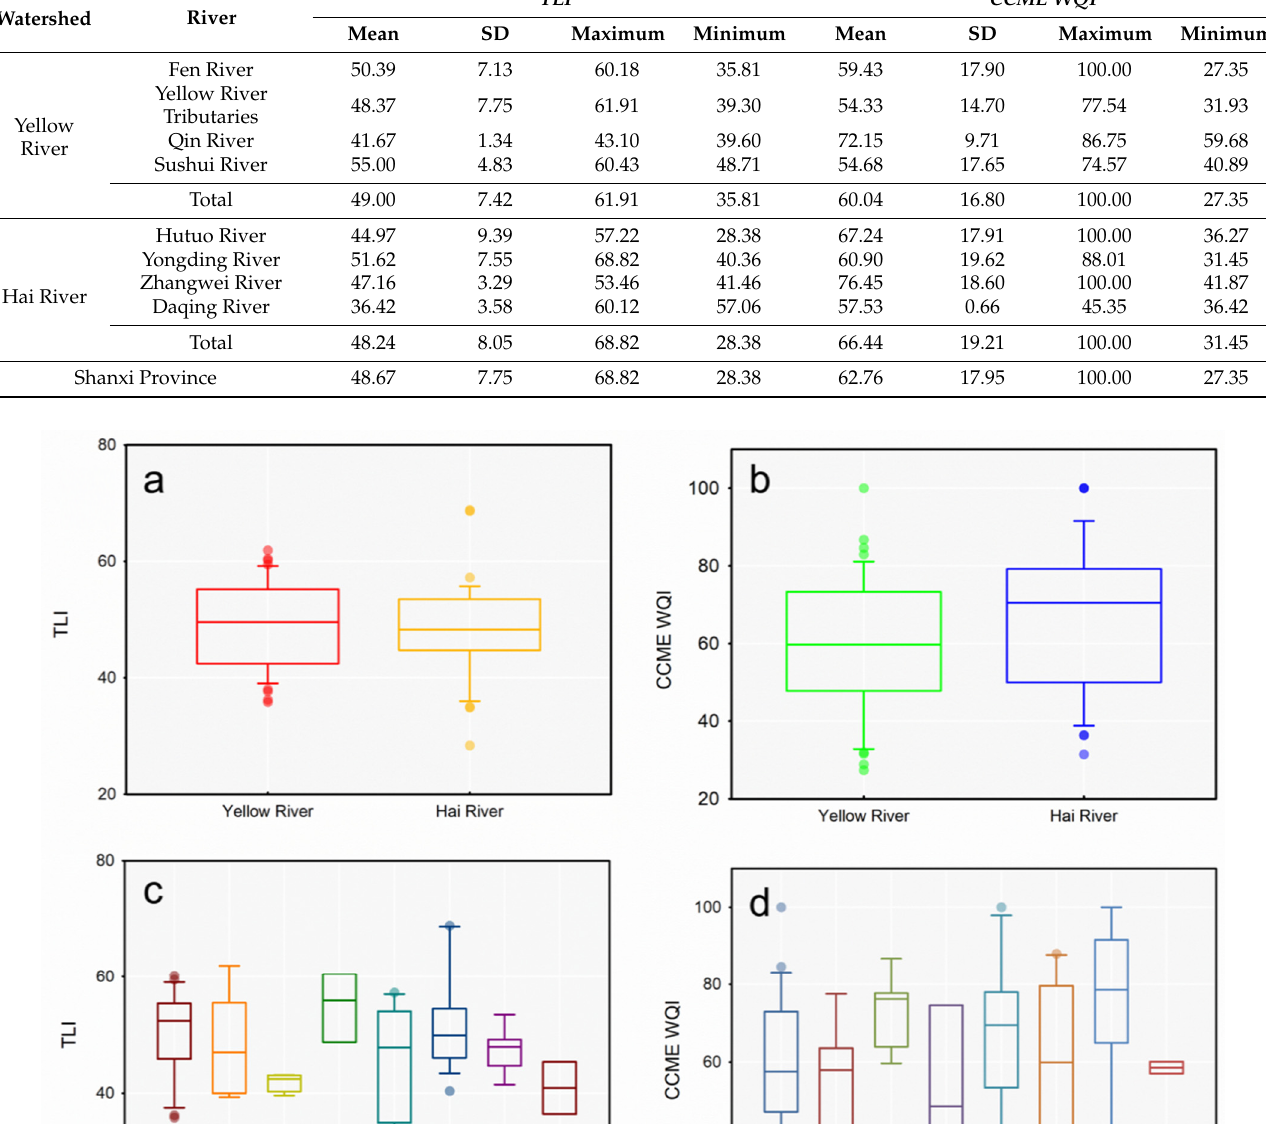
Figure 4. Box plots of the trophic state and water quality in different watersheds and rivers. ( a , c ) comparison of TLI index in different watersheds and rivers; ( b , d ) comparison of CCME WQI index in different watersheds and rivers. FR: Fen River, YRT: Yellow River Tributaries, QR: Qin River, SR: Sushui River, HR: Hutuo River, YR: Yongding River, ZR: Zhangwei River, DR: Daqing River.